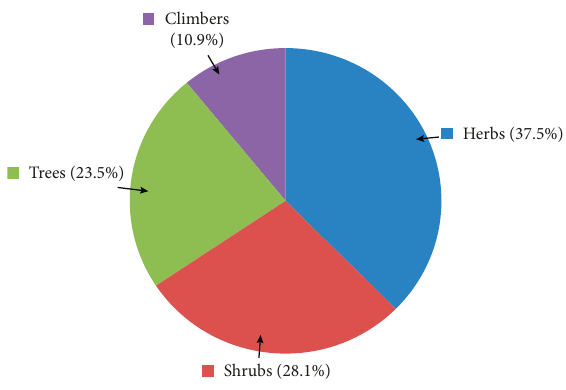
Figure 2: Life form of the plants used as herbal remedies.